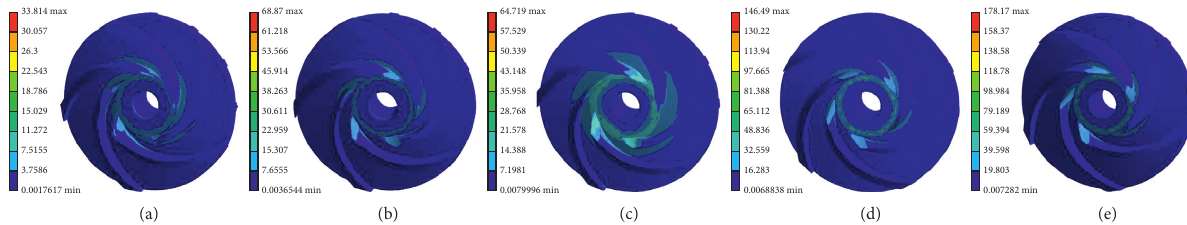
Figure 9: Equivalent stress diagram of the impeller surface. (a) 1 atm. (b) 3 atm. (c) 5 atm. (d) 8 atm. (e) 10 atm.